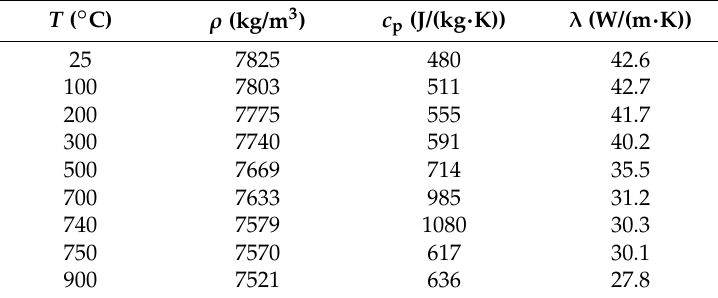
Table 4. Ferrite and pearlite physical properties.